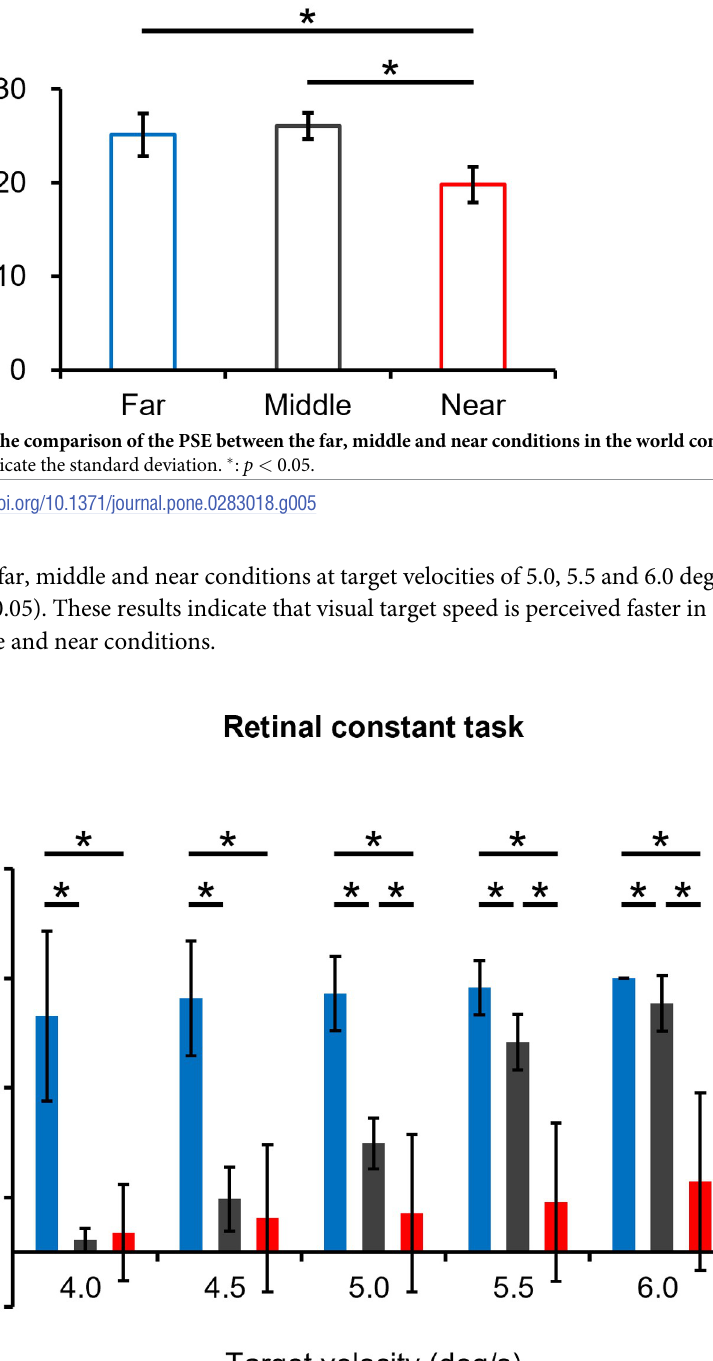
Fig 6. The comparison of the probabilities between the far, middle and near conditions in the retinal constant task. Colors indicate the three different initial positions of the target from the participants: blue, black and red bars are the far, middle and near conditions, respectively. Error bars indicate the standard deviation. � : p <